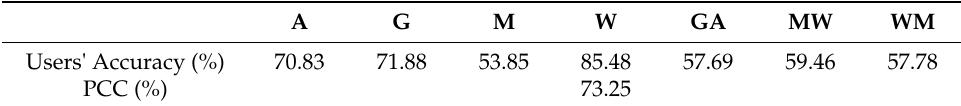
Table 2. Error matrix for change detection (A: arable, G: grass, M: mixed, W: water, GA: grass to arable, MW: mixed to water, WM: water to mixed). PCC, percent correctly